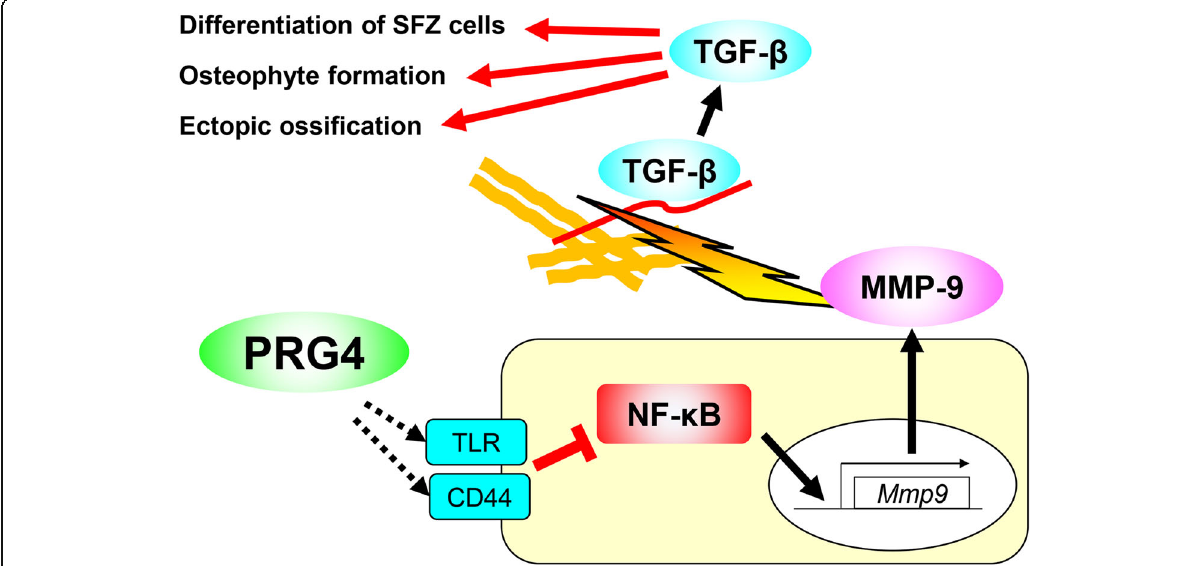
Fig. 1 Schematic diagram representing the molecular pathway in which PRG4 suppresses the differentiation of SFZ cells, osteophyte formation, and ectopic